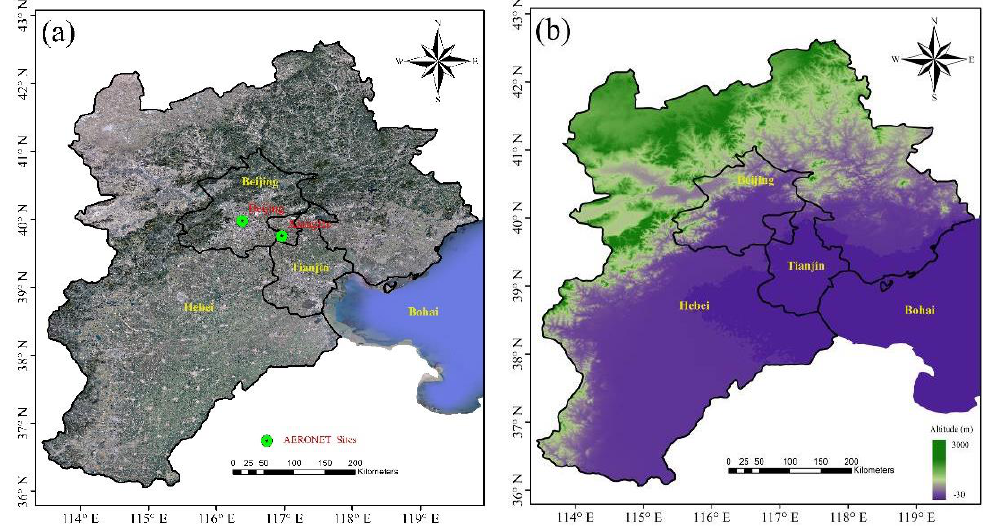
Figure 1. Geophysical information of studying area. (a)The RGB of BTH from Google map and locations of AERONET sites, (b) is the elevation map of